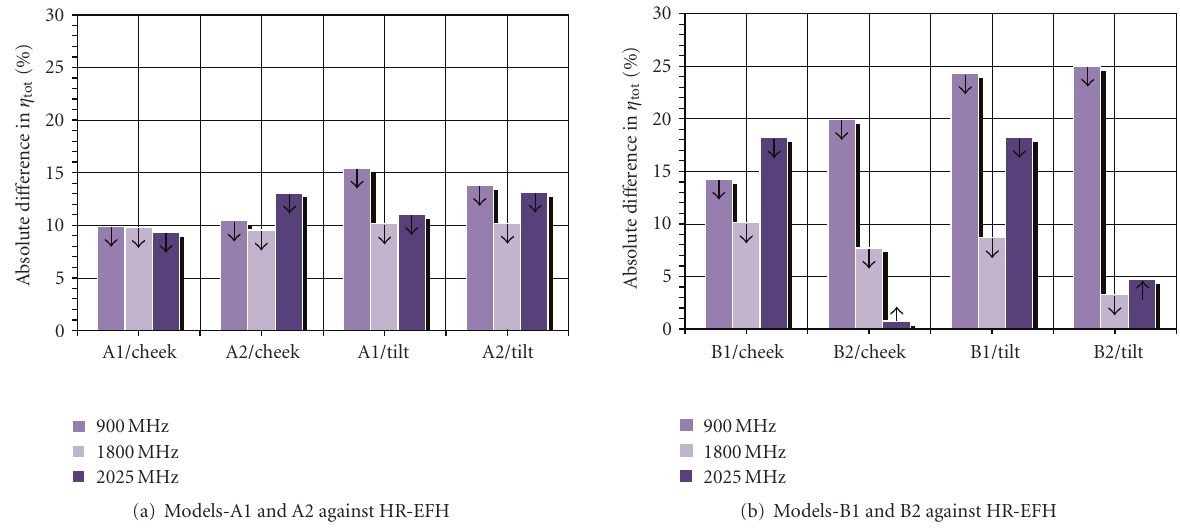
Figure 11: Absolute di ff erence in the antenna total e ffi ciency owing to hand-hold alteration at di ff erent antenna/handset positions against HR-EFH in GSM900, GSM1800, and UMTS/IMT-2000bands.